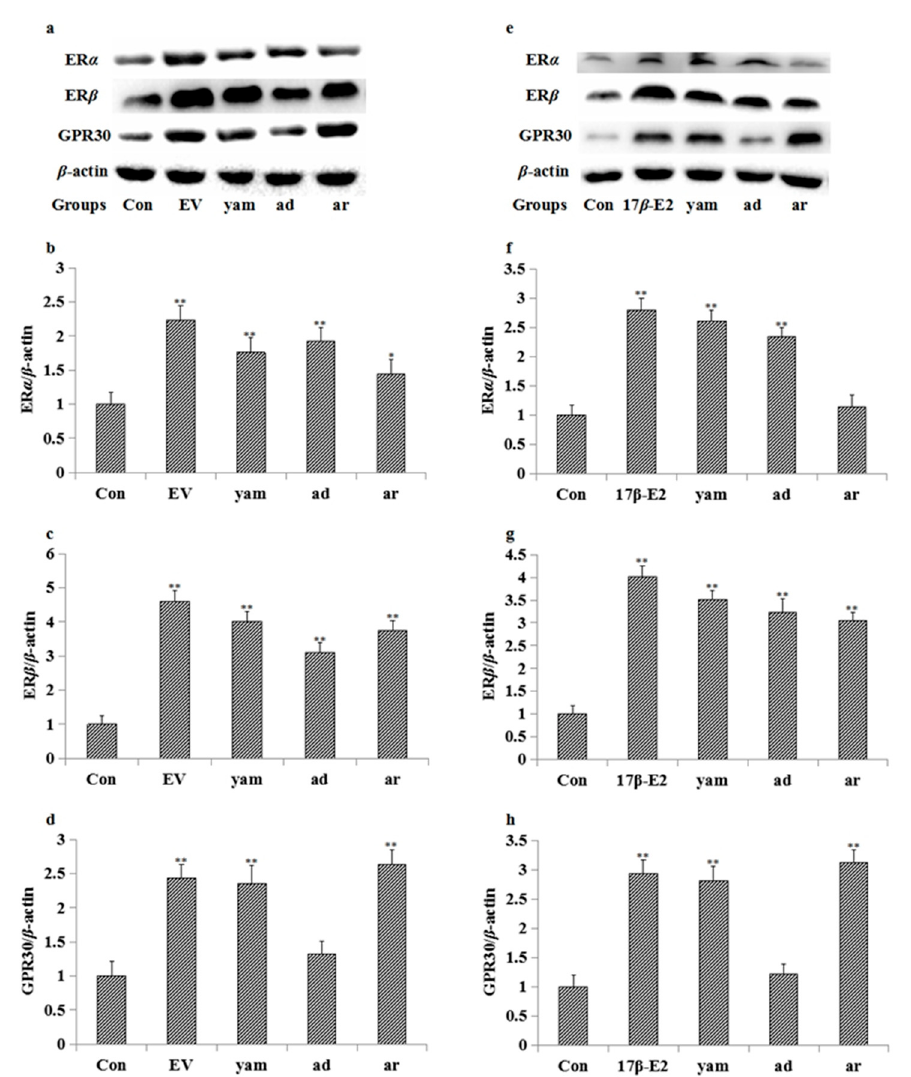
Figure 3. The expression of ER α , ER β , and GPR30 in the uterus and MCF-7 cells tested by the Western blot method ( n = 3). ad: adenosine, ar: arbutin. ( a – d ) were the expression of ER α , ER β , and GPR30